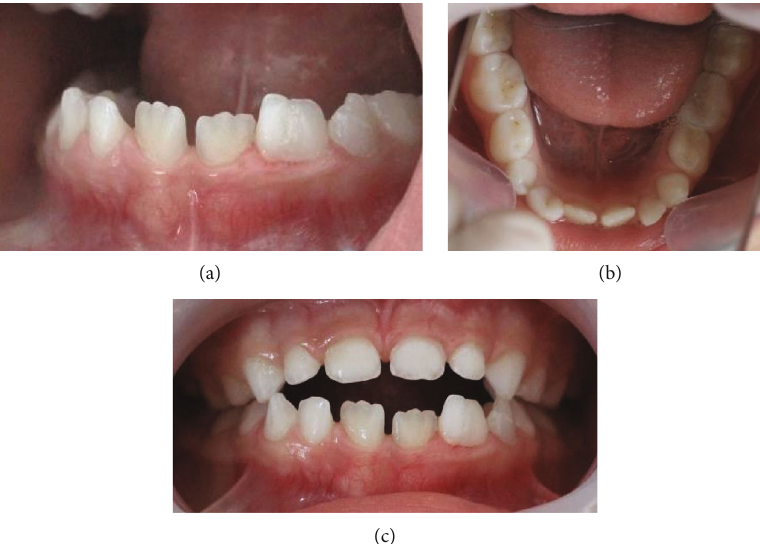
Figure 10: Intraoral photographs of the fused tooth 72 at the 6-month follow-up visit. Stable state with no pathological problems in the two teeth (72 and 73) (a). Occlusal view revealing the anterior teeth proper alignment (b). Photograph of occlusion showing the patient ’ s anterior open-bite